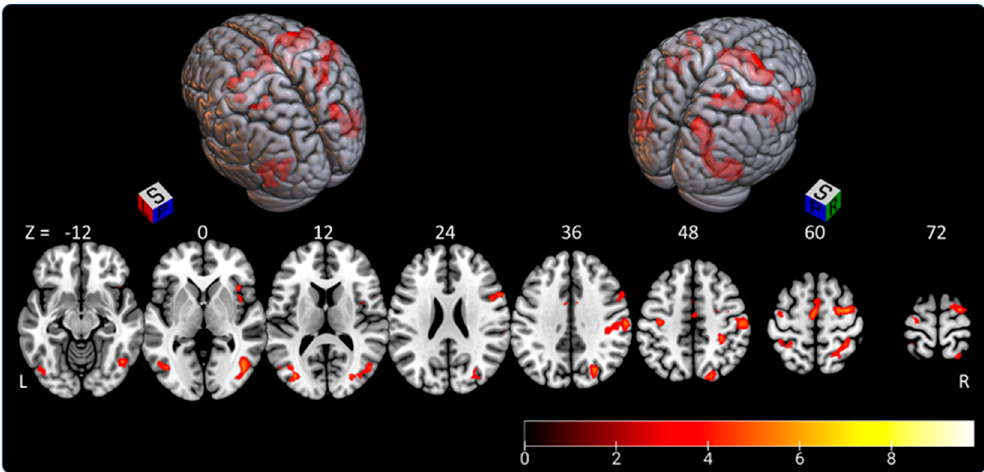
Figure 4. Rendered image of activated clusters highlighted by “SLB > control condition” contrast. The color bar indicates t -values (BOLD); L—left, P—posterior, R—right, S—superior, Z—coordinates in MNI atlas. Table 2. Activated areas highlighted by “SLB > control condition” contrast. The number of voxels is given for each cluster, together with the side (i.e., left or right hemisphere), the cluster composition (i.e., the percentage of voxels in each area assigned using AAL3 and brainnetome atlas), MNI coordinates and t value of the peak. Only activated areas covering more than 10% of the cluster are shown.